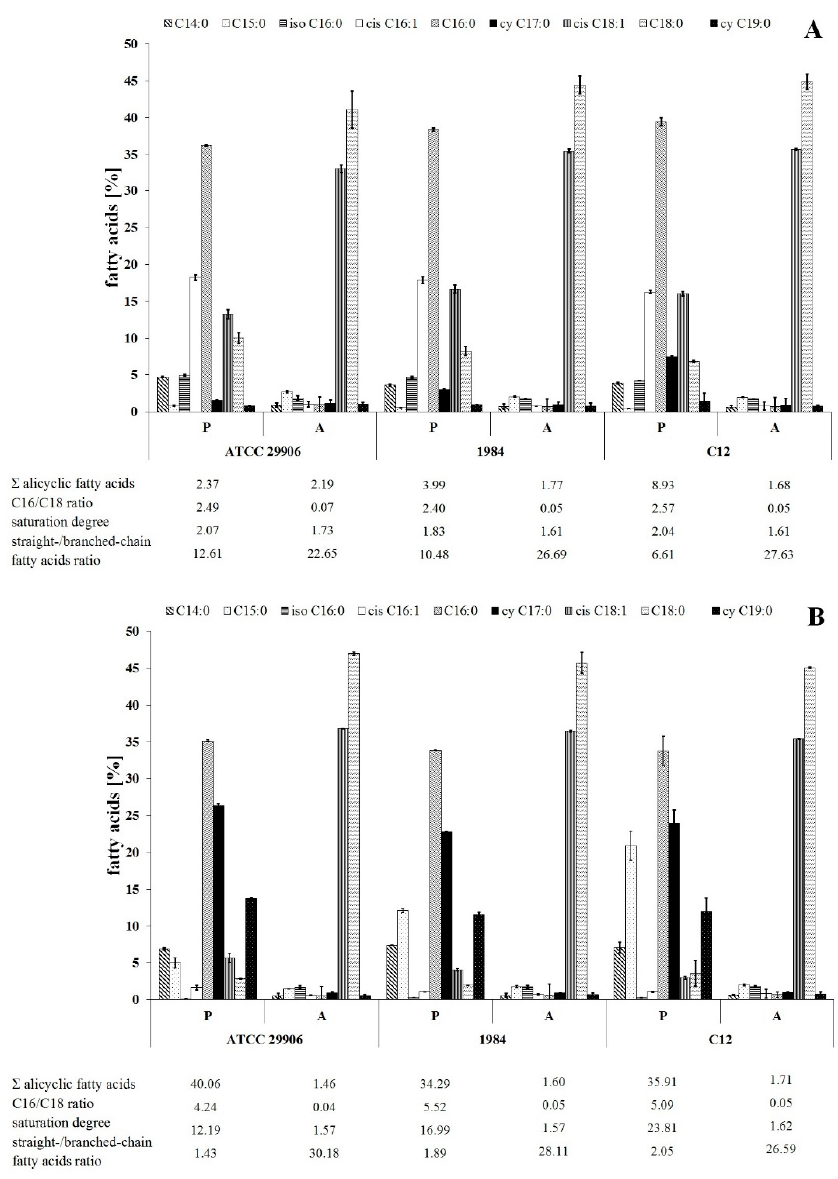
Figure 2. Relative abundances of fatty acids isolated from both the outer and the inner membranes of 6 h ( A ) and 24 h ( B ) planktonic (P) and adherent (A) cells of P. mirabilis ATCC 29906, 1984 and C12.